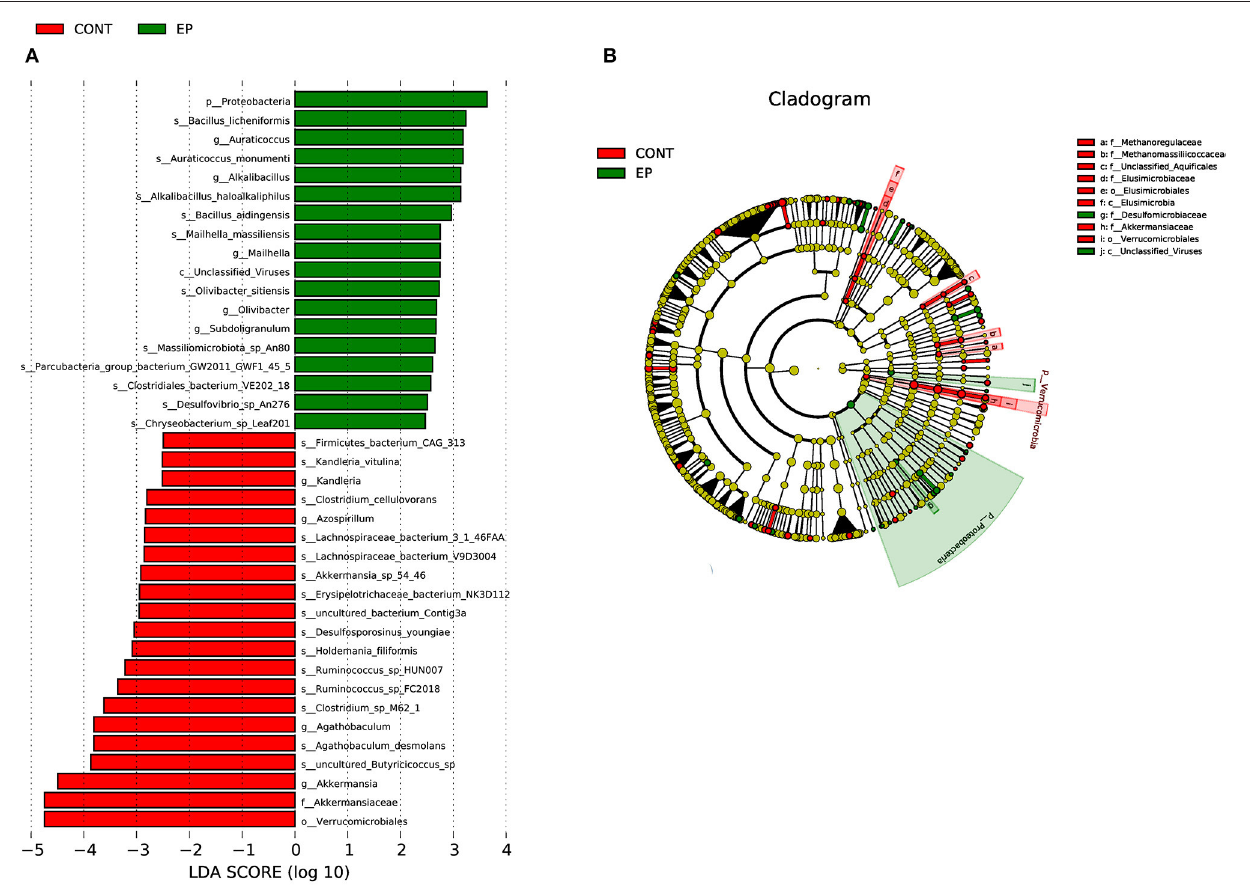
FIGURE 6 | Linear discriminant analysis (LDA) effect size (LEFSe) analysis identified microbial taxa between EP (green) and (control (red) groups. (A) histogram plot from LEfSe analysis that presents the LDA scores of microbial taxa whose abundance showed significant differences between EP supplemented and control group broiler chickens (LDA score > 2.5). The length of the bar column represents the LDA score. (B) The cladogram, circles radiating from inner side to outer side represents the differences in the relative abundance of taxa from phylum to genus level between EP and control group. The red and green dots indicate a significant difference in the relative abundance between EP and the control